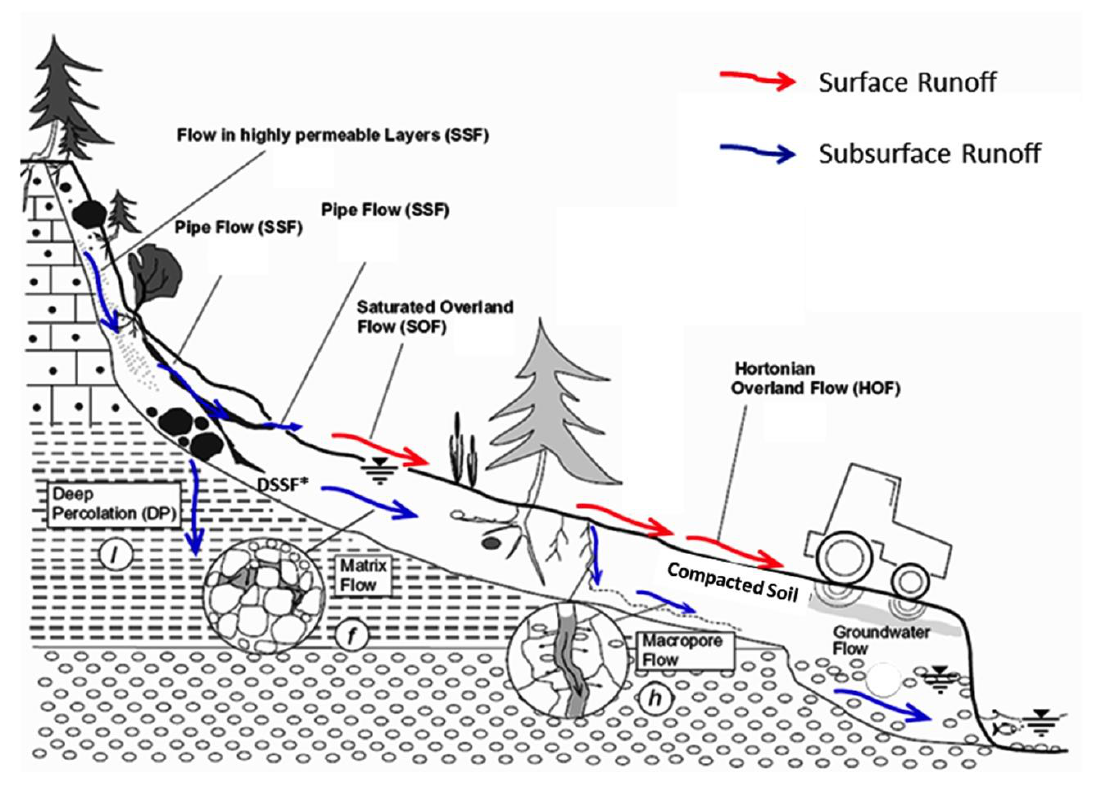
Figure 2. Dominant Runoff Processes (DRP) on a slope (Scherrer [5] and * Schüler [6],